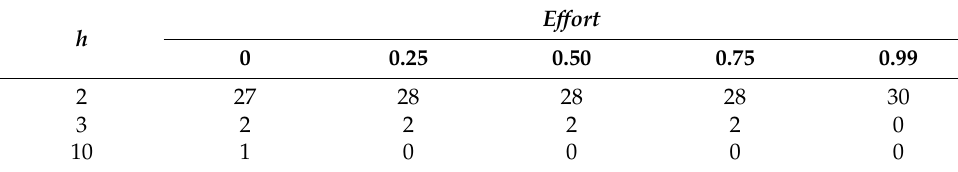
Table 1. Estimates of h for the values of the parameter effort in MA.